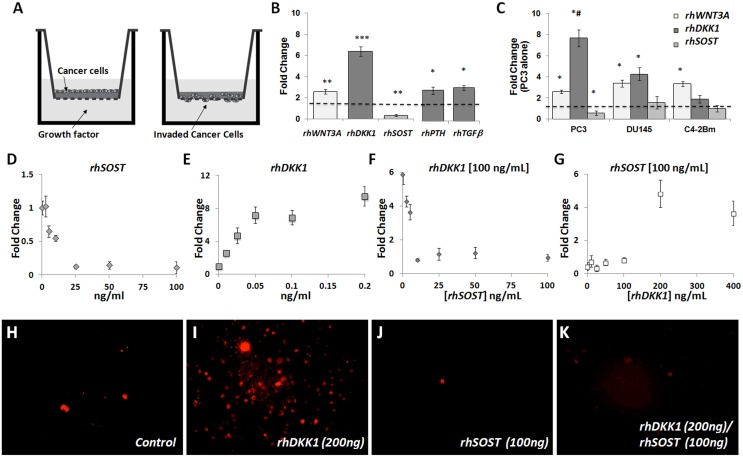
PC cell invasion.A, schematic representation of the invasion assay. B, invasive potential of PC3 cells following 48 hours of co-culture with recombinant proteins. C, the effect of rWNT3a, rDKK1, and rSOST on the invasion of PC3, DU145, and C4-2Bm. D-E, dose response curve of PC3 cells to rSOST or rDKK1. F-G, Dose response curves of PC3 cell invasion when either rDKK1 or rSOST was held constant and the other was incrementally increased. H-K, representative images of PC3-mKate cells following co-culture conditions. Results are expressed as fold change ± SEM. * P<0.5, ** P<0.1, *** P<0.01.